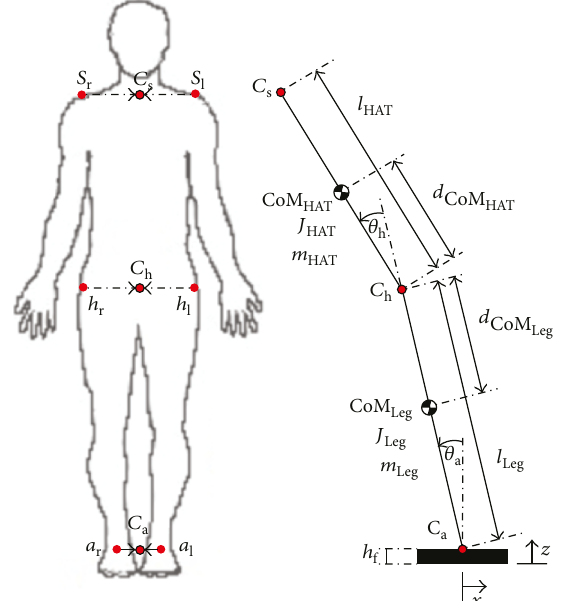
Figure 1: The marker positions (as in the experiment) at ankle, hip, and shoulder and their corresponding centers and the DIP model with: feet (height h ), ankle joint (de fi ned by C and angle: Θ ), f a a and C (de fi ned by: l , COM which Leg segment between C a h Leg Leg from C and by m , and inertia J ), hip joint ( C , is at d COM HAT h Leg Leg h Θ ), and the HAT segment between C and C ( l , COM at h h s HAT HAT from C , and by m , J d COM HAT h HAT HAT